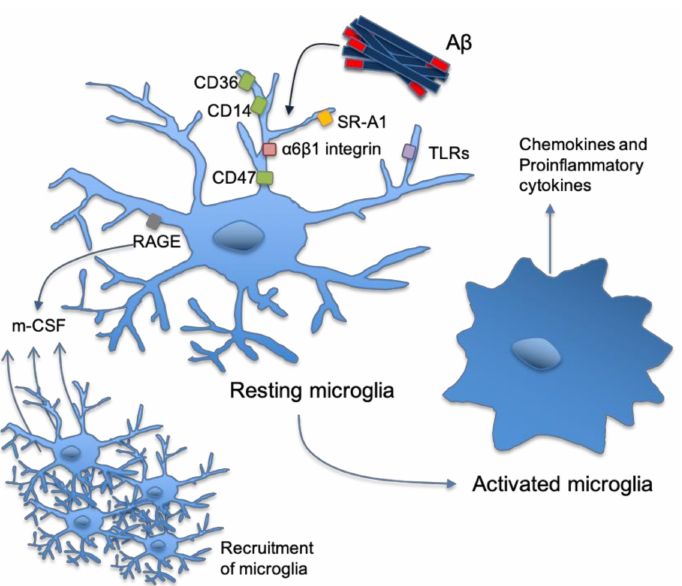
Figure 2. Microglia-amyloid- β interaction. Microglia bind to A β via receptors including class A scavenger receptor A1, CD36, CD14, α 6 β 1 integrin, CD47, and toll like receptors (TLR2, TLR4, TLR6, and TLR9). The binding of A β with CD36, TLR4, and TLR6 results in activation of microglia which start to produce proinflammatory cytokines and chemokines. Binding to RAGE receptor results in the secretion of m-CSF, which recruits more microglia, whereas scavenger RA binding results in ROS secretion via activation of the NADPH oxidase complex exerting neurotoxic